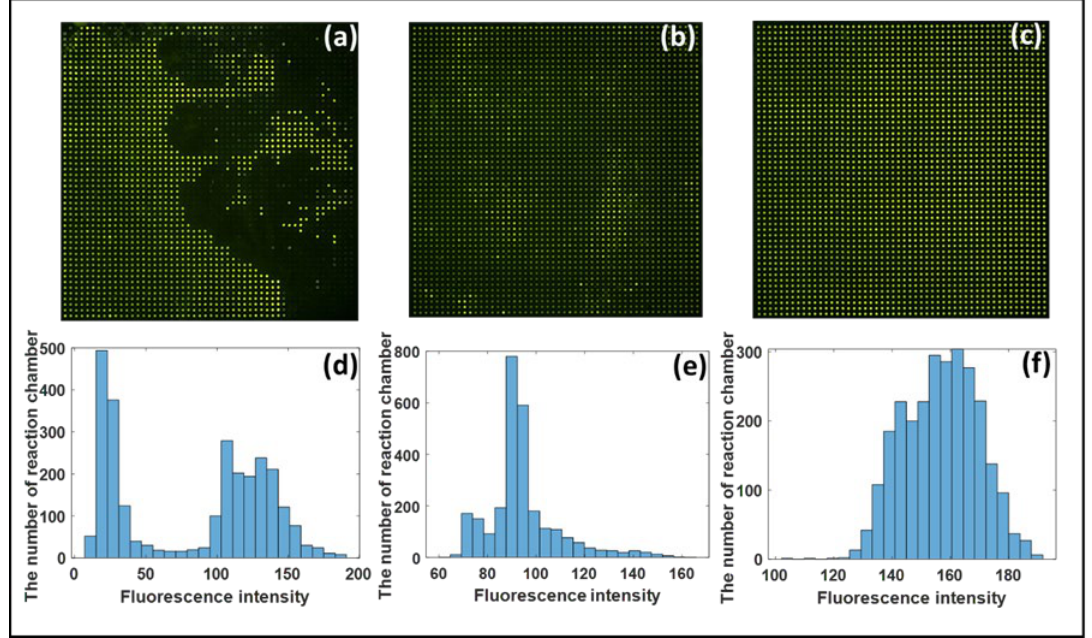
Figure 6. Anti-evaporation effect tests using fluorescein amidite for dPCR chips under different pressures: ( a ) Under standard atmospheric pressure; ( b ) under two atmospheric pressures; ( c ) under four atmospheric pressures. Histograms of the fluorescence intensity of every reaction chamber: ( d ) Under standard atmospheric pressure; ( e ) under two atmospheric pressures; ( f ) under four atmospheric pressures.